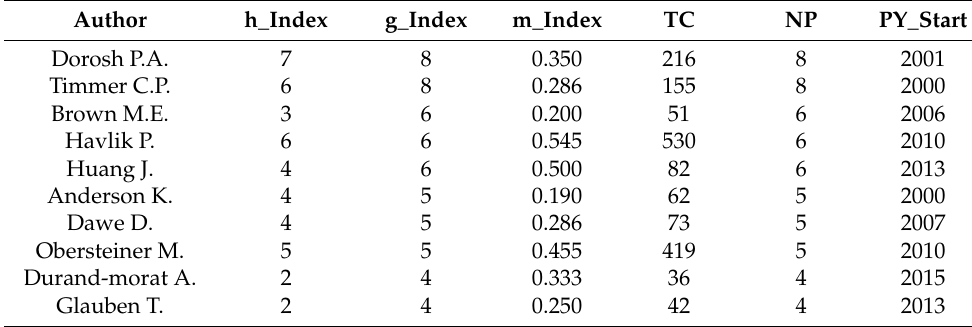
Figure 4. Authors’ production over time. Source. R studio results. Table 6. Authors’ productivity classificationby total